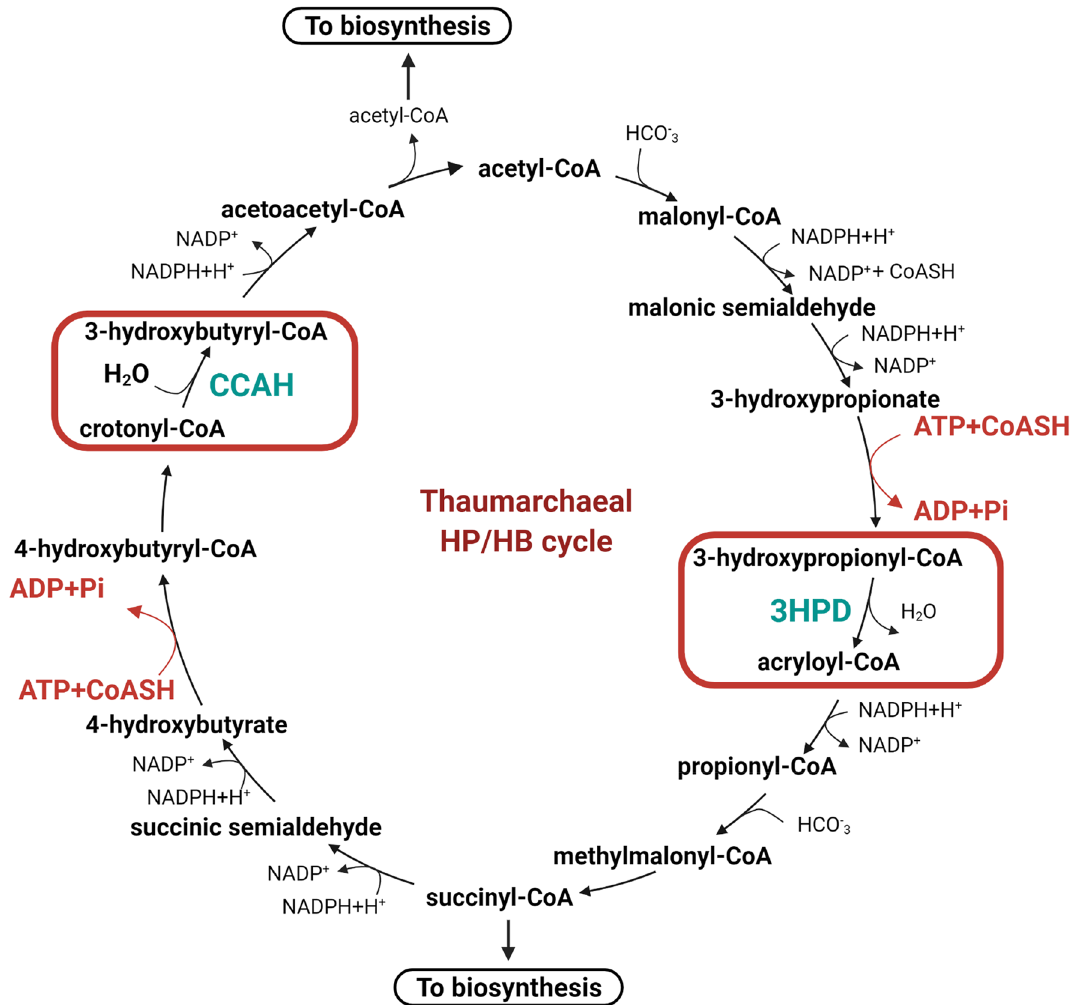
Figure 1. The dual enzymatic steps catalyzed by Nmar_1308 in the thaumarcheal 3HP/4HB cycle. Representation of 3HP/4HB cycle reactions in the thaumarcheal variant. The reaction showing the energy efficiency of the taumarcheal cycle is colored in red. Highlighted rectangle in red indicates the bifunctional reactions catalyzed by the Nmar_1308 protein. Nmar_1308 is a promiscuous enzyme with dual functions that dehydrates 3-hydroxypropionyl-CoA to acryloyl-CoA via 3-hydroxypropionyl-CoA dehydratase (3HPD) and hydrates crotonyl-CoA to 3-hydroxybutyryl-CoA via crotonyl-CoA hydratase (CCAH). 3HPD and CCAH are colored teal. The figure is created with